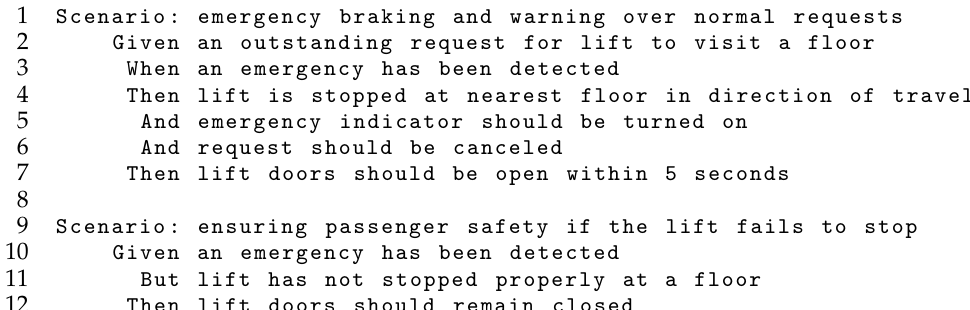
Figure 2. Scheduled sprinkling